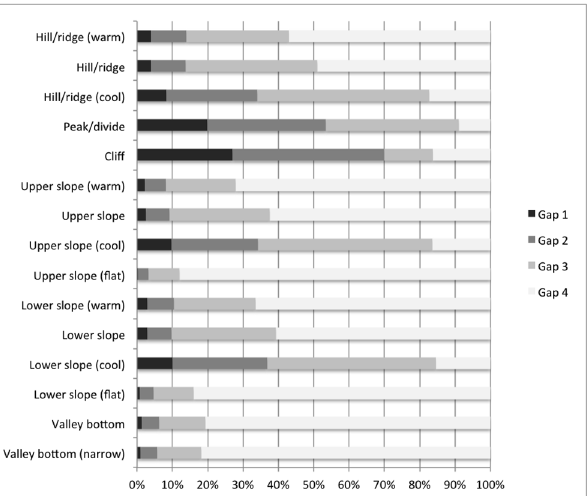
Fig 3. Level of land protection by landform class. Results from a “ gap ” analysis of landforms showing the level of land protection for each land form class. Level of protection follows the gap status classes [48]: